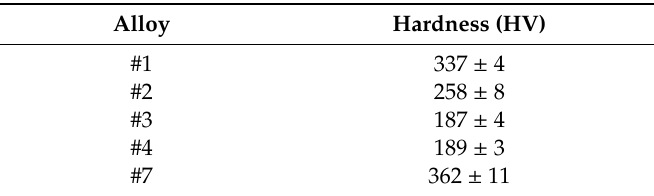
Table 4. Ti-based alloys’ micro-hardness values, (HV).